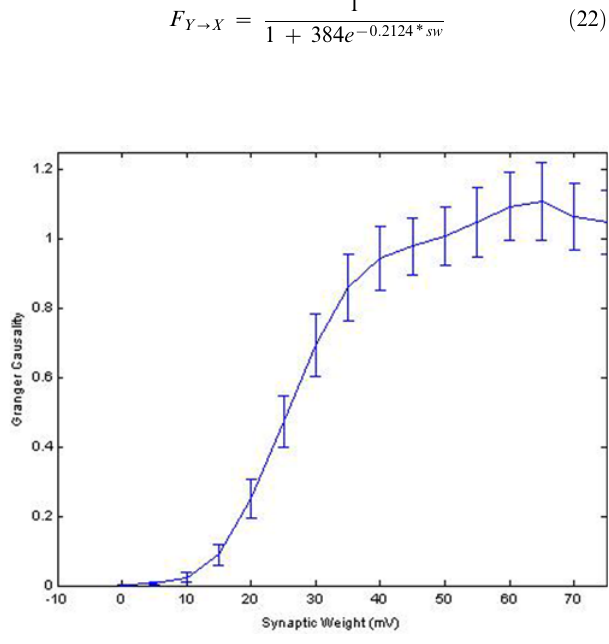
Figure 4. The Relationship Between the Causal Strength From Pairwise Granger causality and Actual Synaptic Weights. The PGC results from a mono-directional simulation with the weight from neuron 4 to 5 varied from 0–75 mV in increments of 5 mV. Synaptic weight is plotted on the x-axis while the resulting PGC values calculated from the spike timing is plotted on the y-axis. The error bars represent the standard deviation of the results of 100 simulations for each point in the plot. The relationship between synaptic weight and PGC is sigmoid described by Equation 12. Notice that only the region in which the synaptic weights are between 15 mV and 45 mV is linearly related with the magnitude of the causality estimate. Areas in which the synaptic weights are very small or very large will result in a distorted causality value that changes very little.